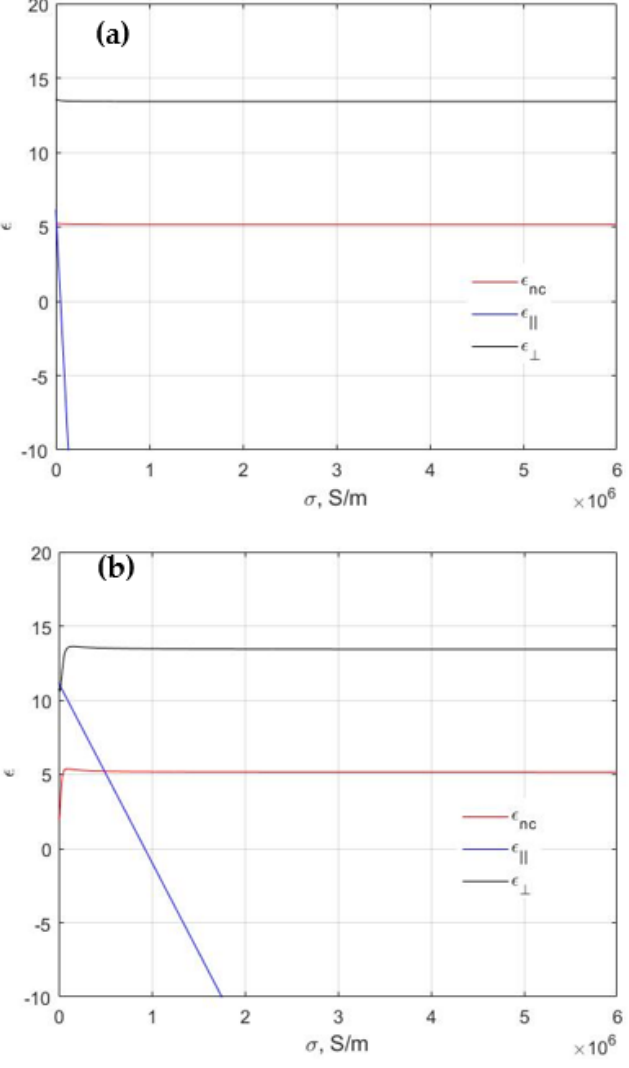
Figure 4. Relative permittivity components of the nanocomposite and hypercrystal versus conductivity. Herein, f = 0.3, ε n = 2.25, ε d = 11.8. Herein ITO inclusions are employed in nanocomposite and hypercrystal. ( a ) ω = 0.3 × 10 14 Hz; ( b ) ω = 3 × 10 14